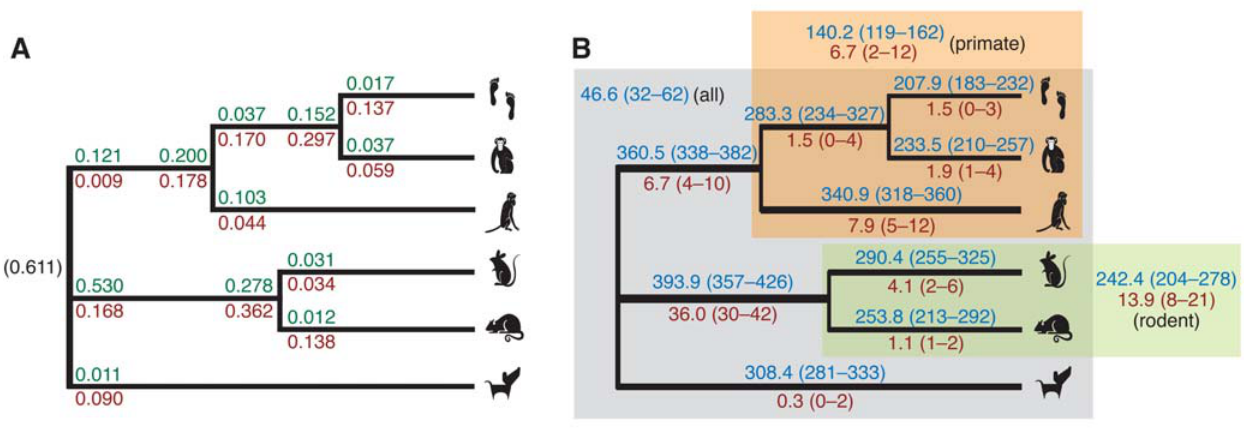
Figure 4. Patterns of positive selection on the mammalian phylogeny. (A) Probabilities that each gene gains (green) or loses (red) positive selection on each branch, under the Bayesian switching model. Switching events are allowed to occur early (near ancestor) or late (near descendant) on internal branches, and early on external branches. The prior probability of selection at the root of the tree is shown in parentheses. (The primate- rodent ancestor is treated as the root for this analysis; see Text S1.) The values shown are posterior means. The full posterior distributions are summarized in Figure S2. (B) Expected numbers of genes under positive selection on each branch (blue) and under positive selection only on each branch (red), out of the 544 PSGs examined, with 95% credible intervals in parentheses. Branch thicknesses are proportional to numbers in blue. Similar estimates are also shown for genes under positive selection on all branches of the primate and rodent clades (blue), on only the branches of these clades (red), and on all branches of the tree (blue). All estimates are based on 10,000 iterations of the Gibbs sampler, excluding a 100 iteration burn-in period. On each iteration, all switching parameters and the selection histories for all genes were sampled (see Text S1).